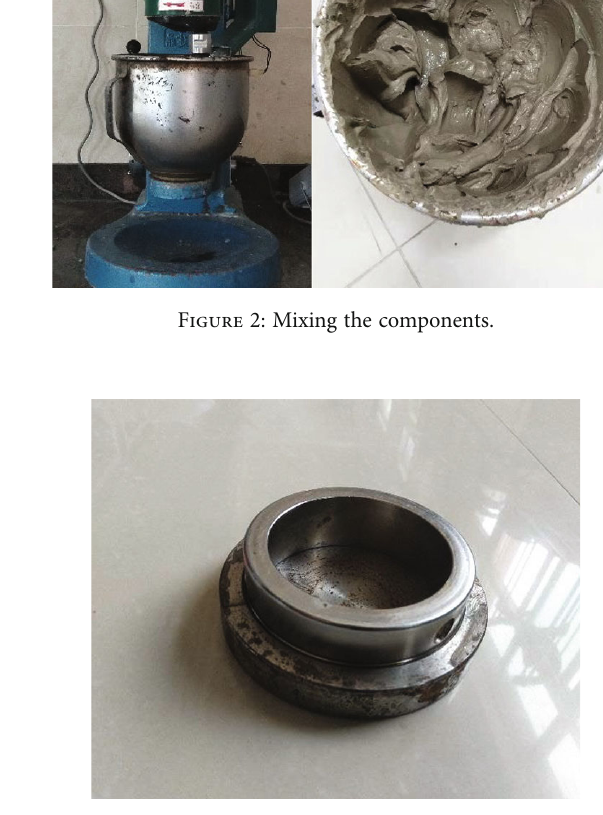
Figure 3: The standard penetration mold.